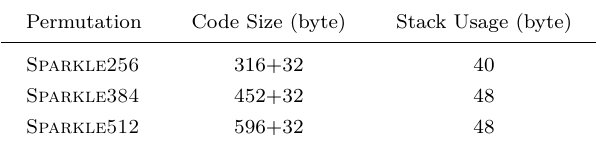
Table 11: Code size and stack consumption of the Sparkle permutations on a 32-bit ARM Cortex-M3 microcontroller. The code size is given as the number of bytes the permutation occupies in the text segment plus the 32 bytes for the round constants.